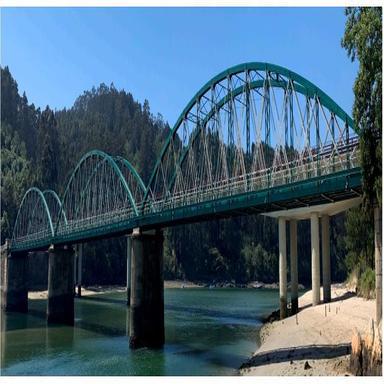
Overall view of O Barqueiro Bridge.